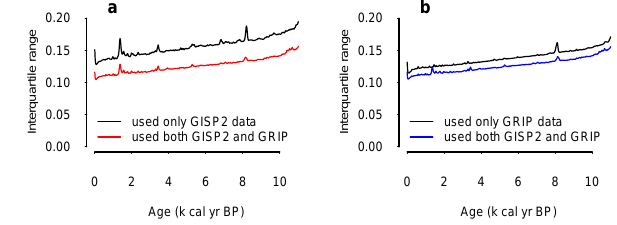
Figure6. Plotsoftheinterquartileranges(IQR;correspondingtothewidthofthe50%crediblebandinFig.5) Figure 6. Plots of the interquartile ranges (IQR; corresponding to ofthemarginalposteriordistributionsof x g onabidecadaltimegridovertheperiodof0to11kcalBPatcore the width of the 50% credible band in Fig. 5) of the marginal pos- (a) GISP2and (b) GRIP.Themainfeaturesfromtheseplotsare:(i)interquartilerangesoftheseparatemodels terior distributions of x g on a bidecadal time grid over the period arealwayshigherthanthoseofthejointmodel;(ii)thegapsofthedifferencesin (a) areconsistentlylargerthan of 0 to 11kcalBP at cores (a) GISP2 and (b) GRIP. The main fea- thosein (b) ;(iii)thereareseveralspikes;(iv)aslighttendencyforincreasedIQRfurtherbackintime.Seethe tures from these plots are that (i) interquartile ranges of the separate textforadetaileddiscussion. models are always higher than those of the joint model; (ii) the gaps of the differences in (a) are consistently larger than those in (b) ; (iii) there are several spikes; and (iv) a slight tendency for increased IQR further back in time. See the text for a detailed discussion.